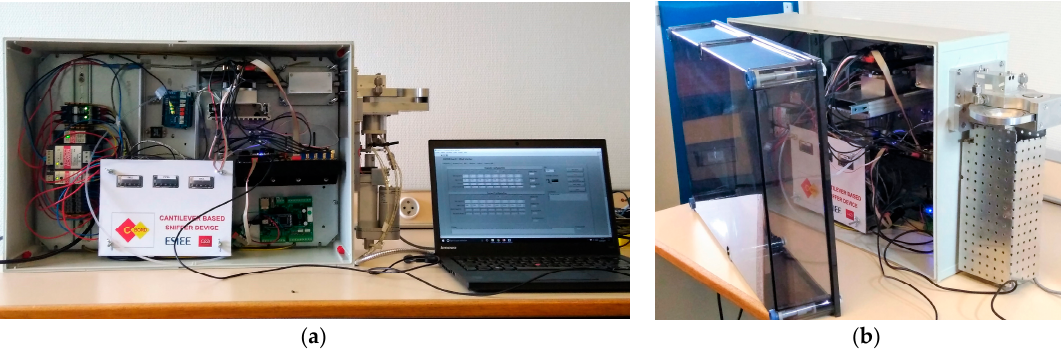
Figure 4. Pictures of the Sniffer System ( a ) A global view of the system: opened box containing the integrated system, the thermodesorber and a computer for human-machine interface ( b ) Another view of the system where we can see more details of the